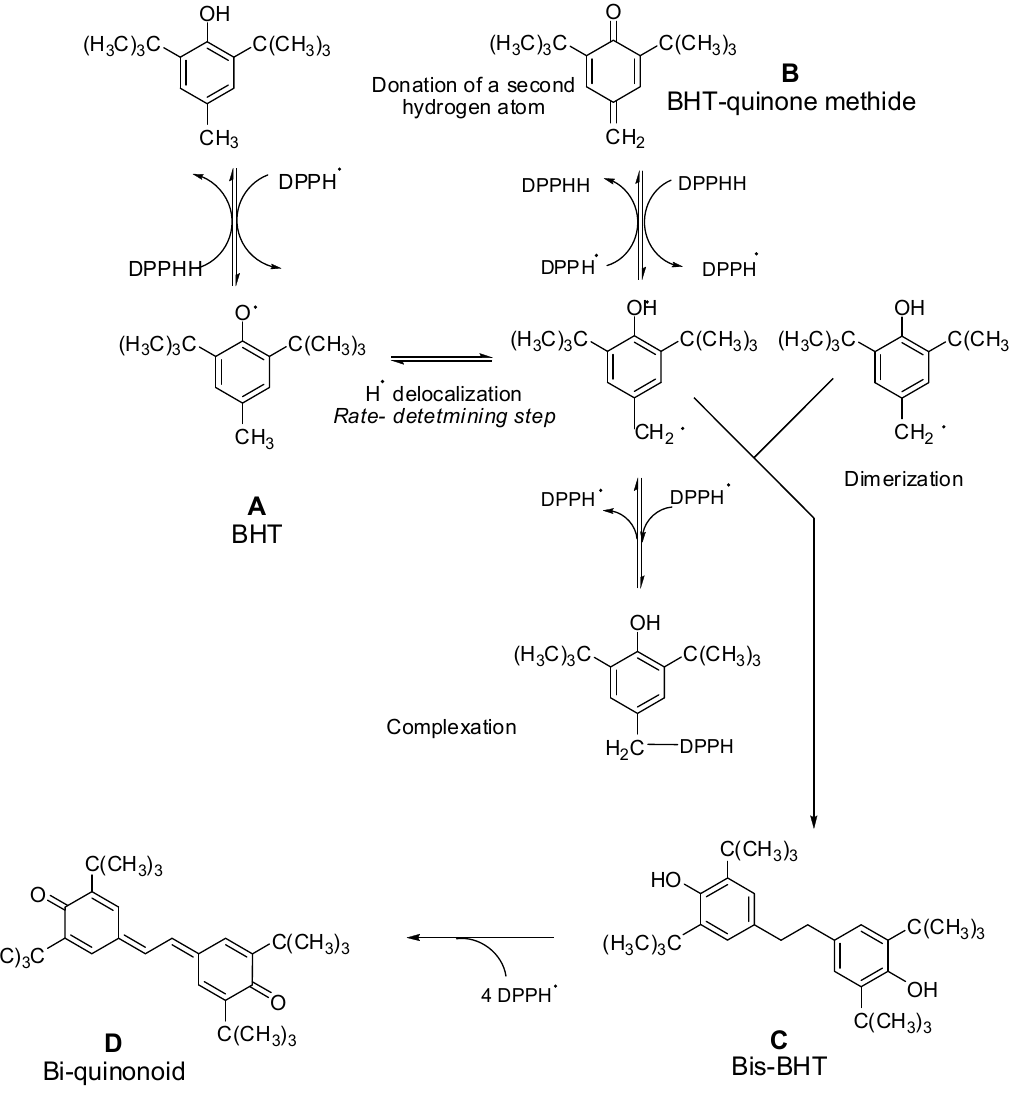
Table 3. IC 50 values and maximum inhibition of activity at 100 µM of the DPPH radical scavenging and lipid peroxidation inhibition